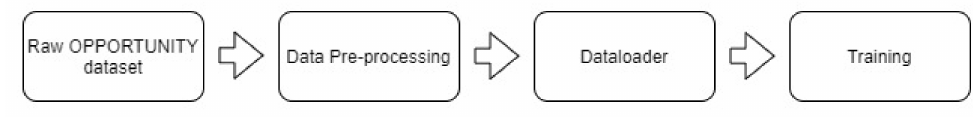
Figure 3. Flowchart for model training